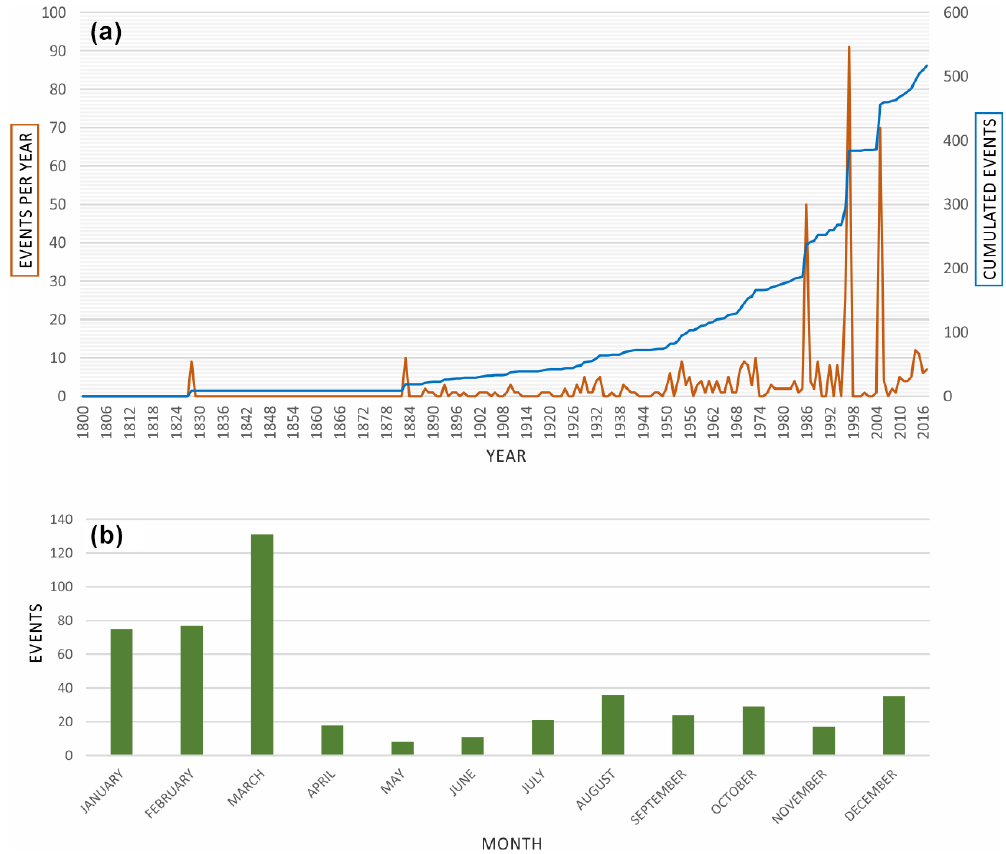
Figure 8. Yearly (a) and monthly (b) distribution of the landslide events characterized by temporal information.